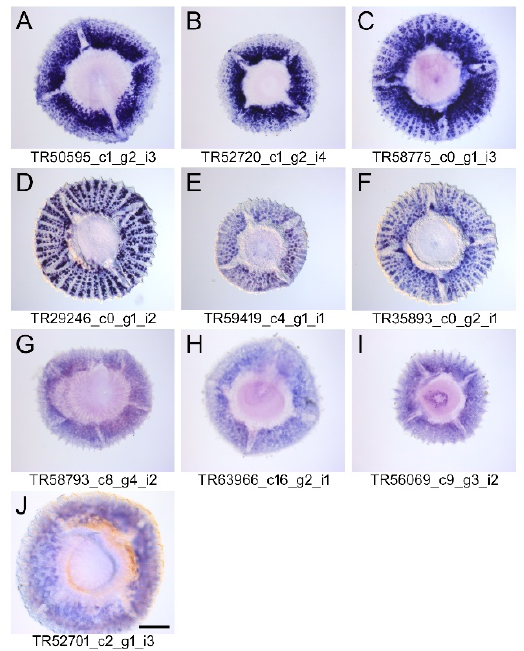
Figure A2. In situ hybridization screen panel 2. ( A – J ) Ventral view onto the tube foot disc. The distribution of the in situ hybridization signal (blue) resembles the localization of the adhesive gland cells bodies plus additional cells of the adhesive disc. Therefore, these transcripts potentially constitute proteins involved in bioadhesion or other proteins of the disc cells. Scale bar, 200 µ m.